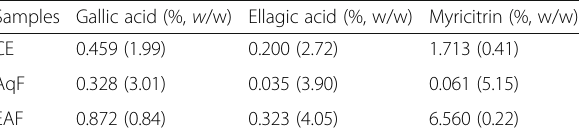
Table 1 Content of the chemical markers assayed in the CE and fractions of E. uniflora leaves as determined by HPLC-DAD